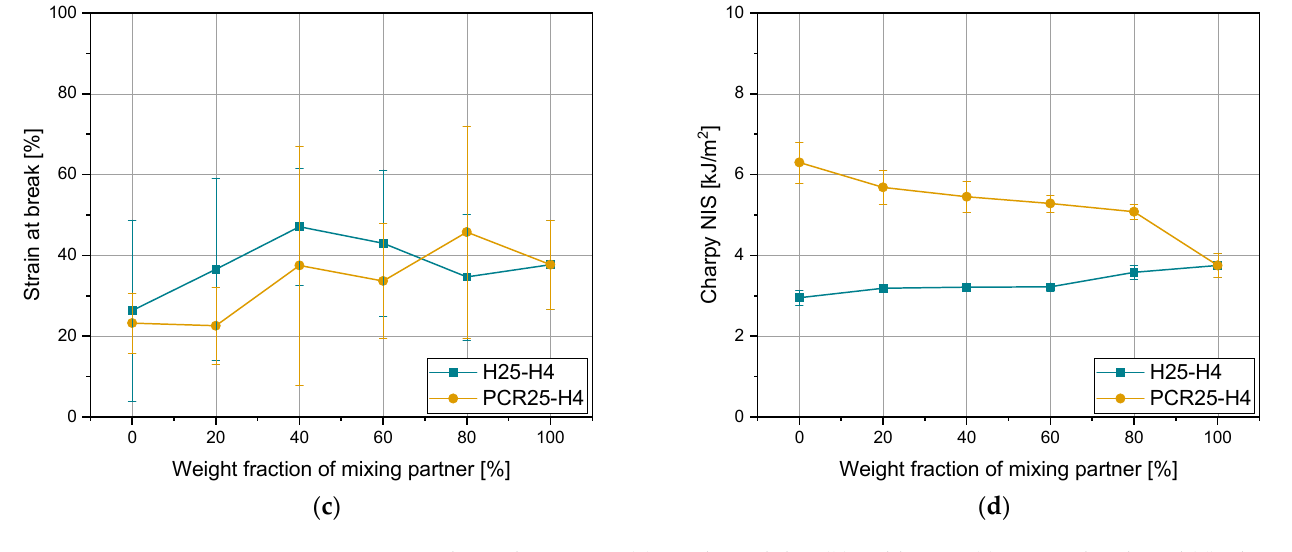
Figure 6 . Mechanical properties ( a ) tensile modulus, ( b ) yield stress, ( c ) strain at break, and ( d ) Charpy NIS of blends with H25 and PCR25.